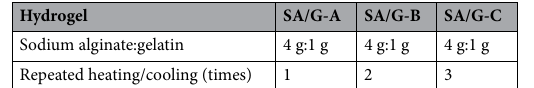
Table 1. Material composition and preparation methods of